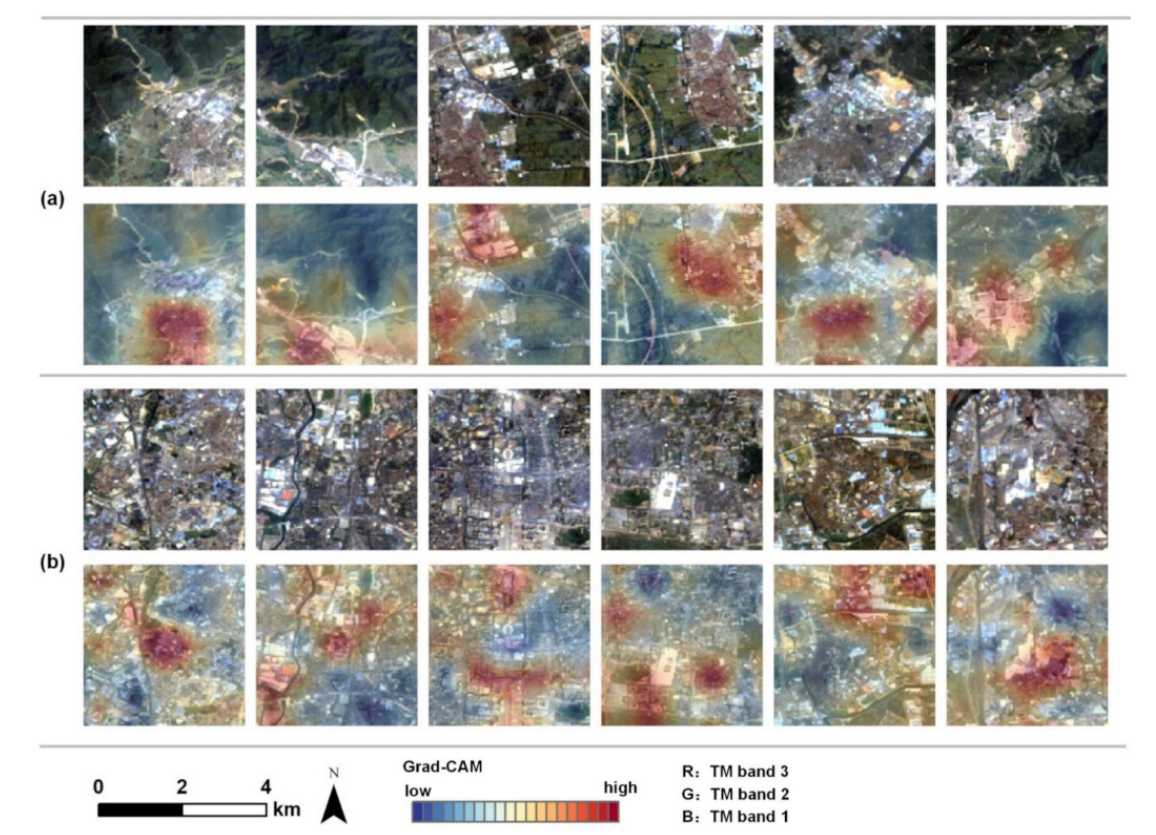
Figure 9. RS image patches ( top row ) and corresponding heatmaps ( bottom row ) produced by Grad-CAM in 12 typical grid cells. ( a ) Built-up areas border natural areas; ( b ) Interiors of built-up